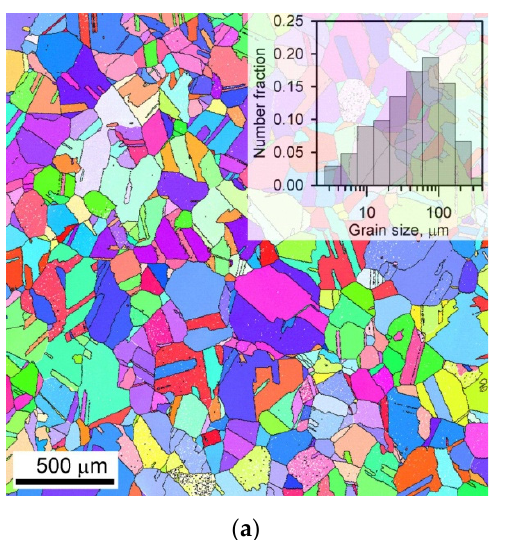
Figure 1. Initial microstructure ( a ) and dispersed particles ( b ) of a Cu-Cr-Zr alloy after solution treatment at 920 °C and aging at 500 °C.